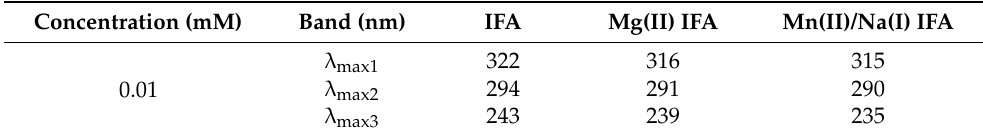
Table 4. The wavelengths of maximum absorbance from the UV/VIS spectra of isoferulic acid and studied